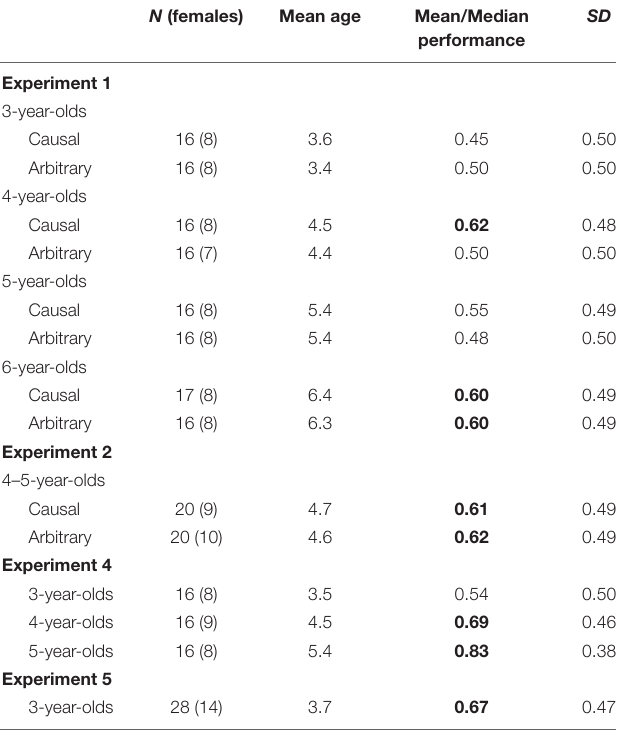
contained pegs that were 7.5 cm apart from each other on